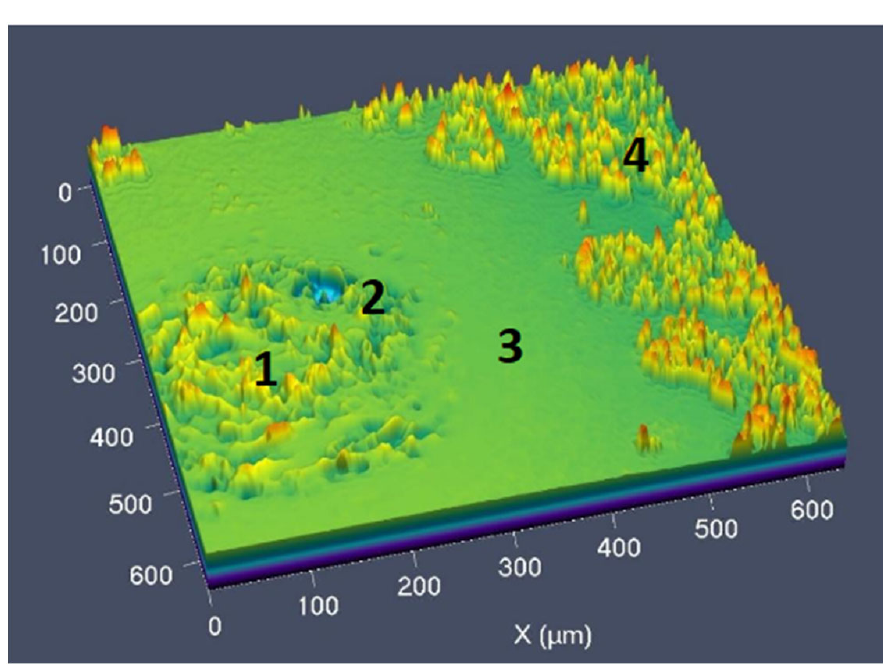
Figure 12. Phases of current propagation through the sample.